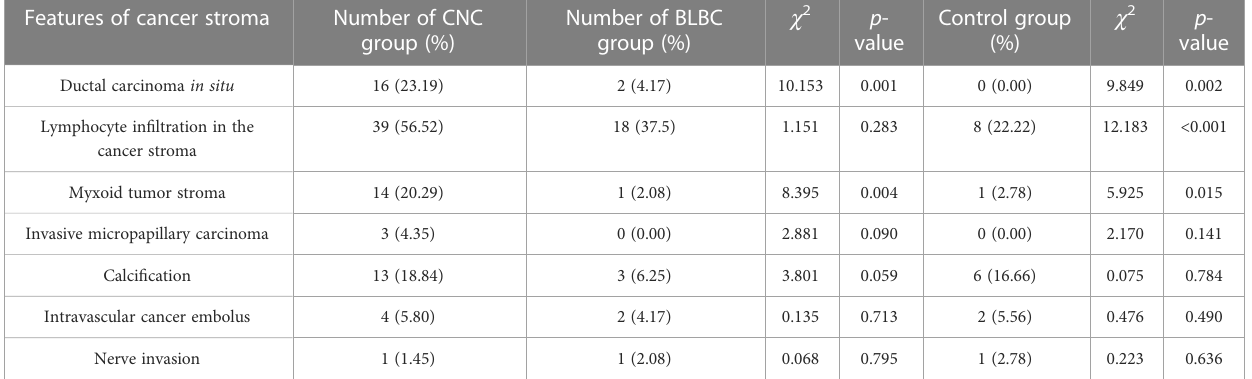
TABLE 2 Comparative analysis of cancer stroma between CNC and BLBC, and between CNC and control group. Features of cancer